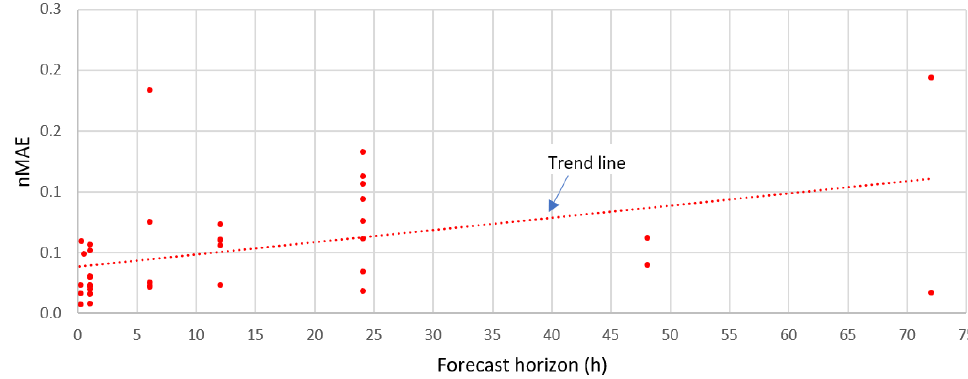
25 of 39 Figure 12. Dependence of nRMSE on forecasting horizon.